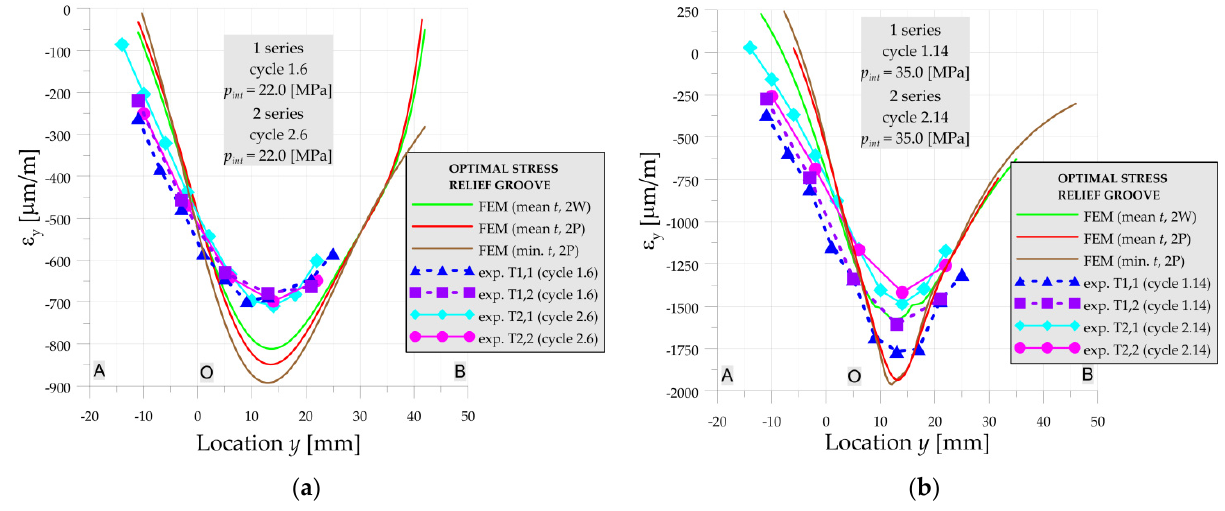
Figure 10. Numerical and experimental strains on line A-O-B, optimal SRG, 1st and 2nd series: ( a ) cycles 6; ( b ) cycle 14.